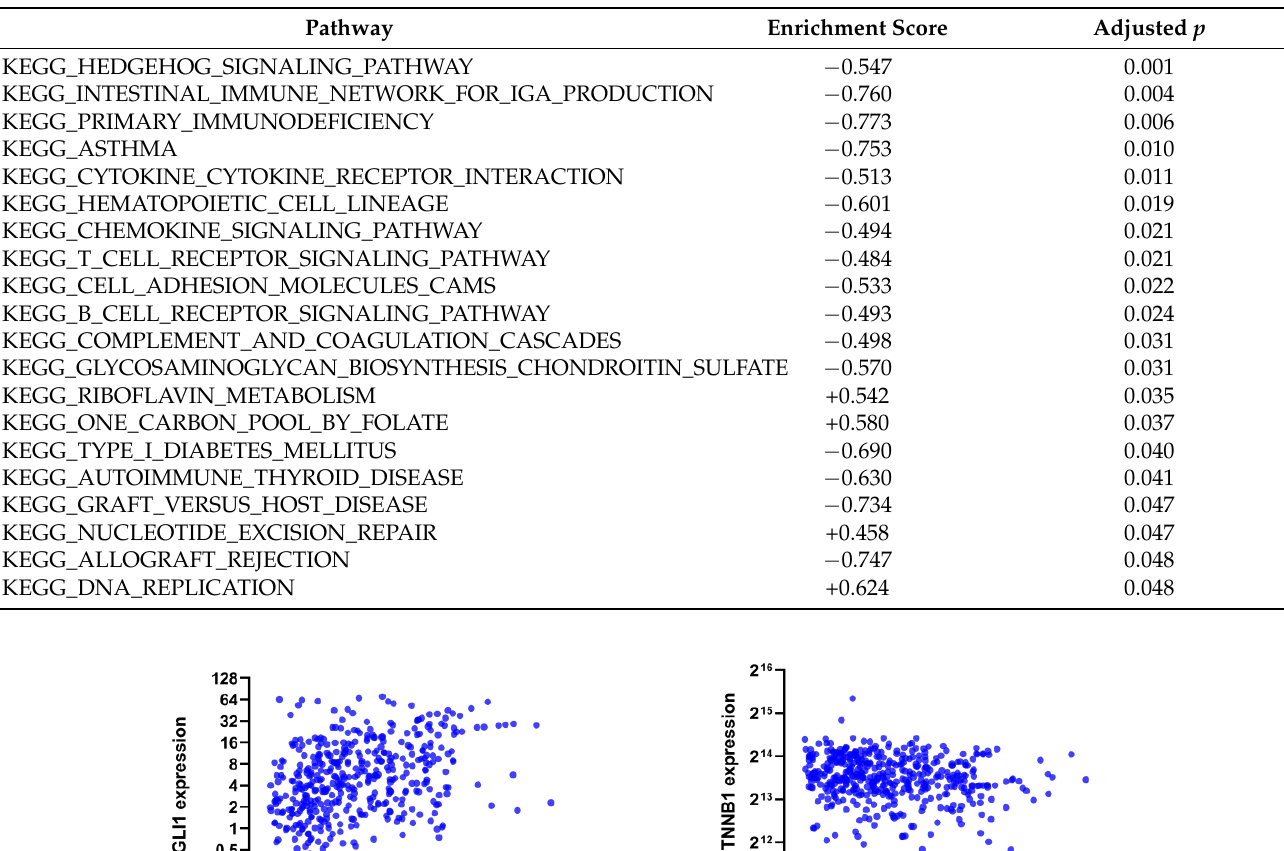
Figure 2. Principal component analysis plots of the gene expression profiling of the propensity score-matched TCGA-THCA dataset, grouped by the expression of ( a ) the sodium iodide symporter (NIS) or ( b ) the BRAF-RAS class. Table 3. Top 20 Kyoto Encyclopedia of Genes and Genomes (KEGG) pathways associated with expression loss of the sodium iodide symporter.